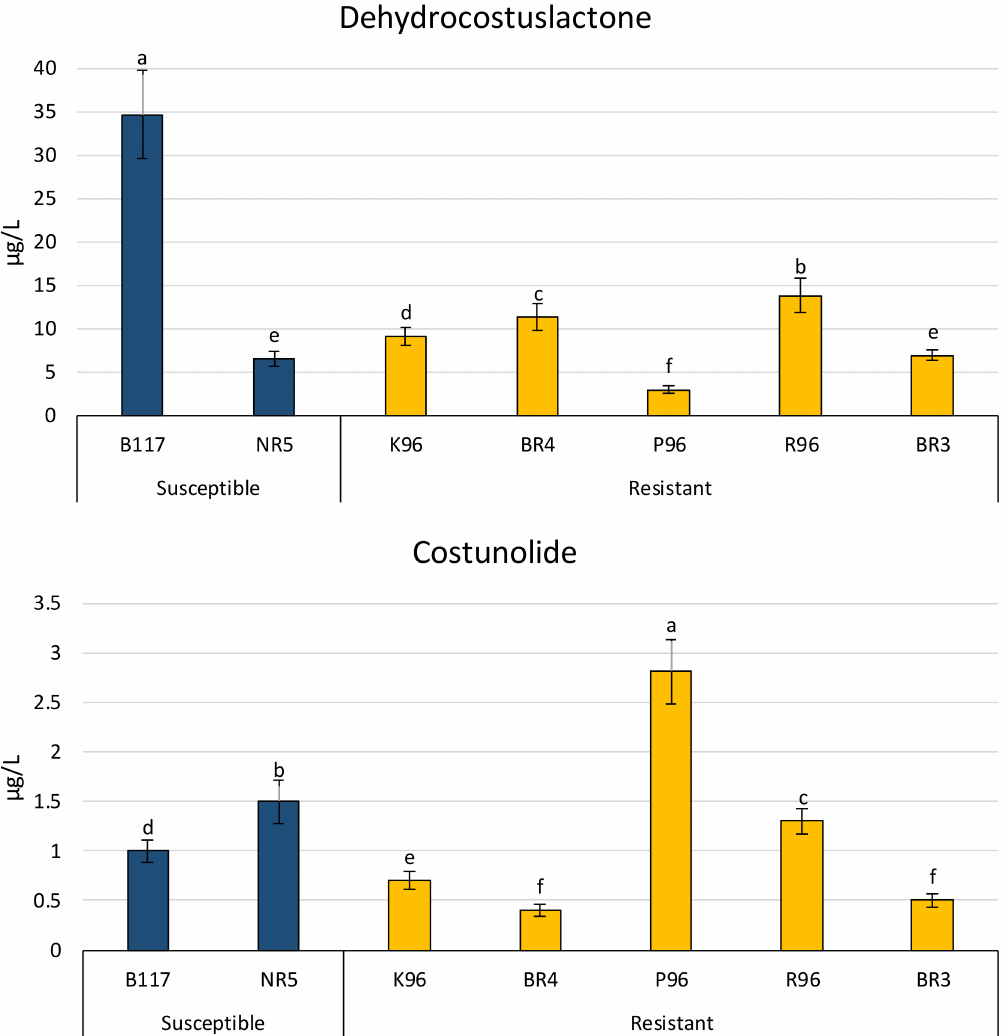
Figure 4. Concentrations of dehydrocostuslactone and costunolide in sunflower root exudates of five resistant varieties (BR4, P96, BR3, K96, and R96) and two susceptible varieties (B117 and NR5). Different letters indicate significant difference ( p < 0.05) according to Analysis of Variance (one-way ANOVA) followed by Newman–Keuls test. Similar letters indicate non-significant